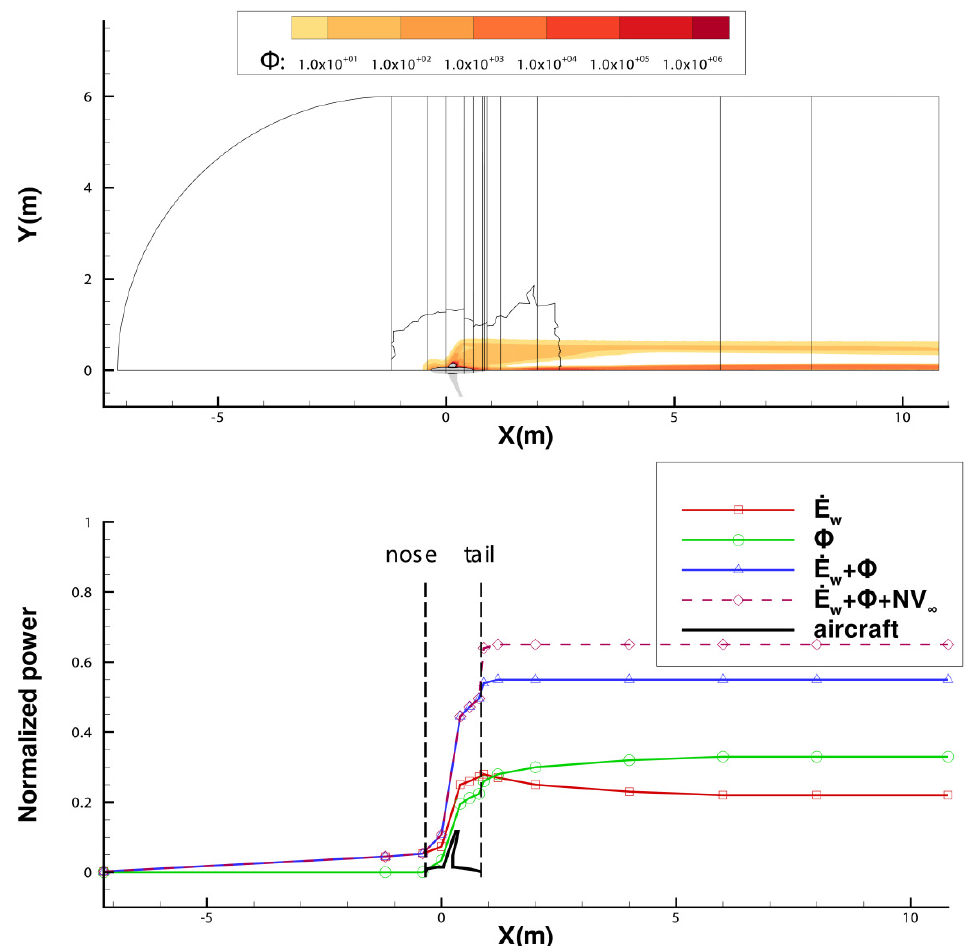
Figure 16. The intensity of viscous dissipation and the power conversion process of the BLI con ‐ figuration.